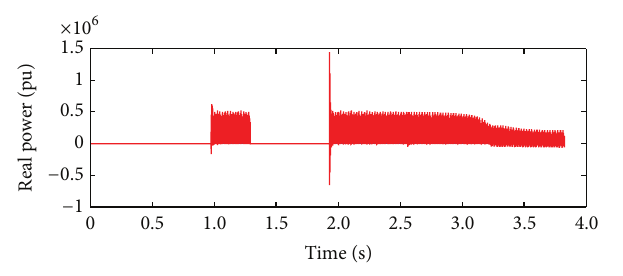
Figure 18: Real power during LLLG fault.